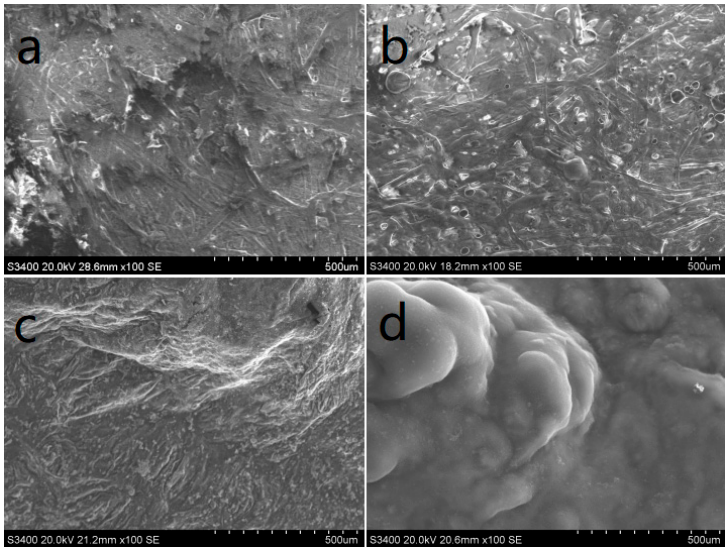
Figure 8. Scanning electron microscopy (SEM) micrographs of chars after LOI test. ( a ) EP; ( b ) EP/30DOPO; ( c ) EP/30P-KC; ( d ) EP/30DOPO-P-KC (2:1).